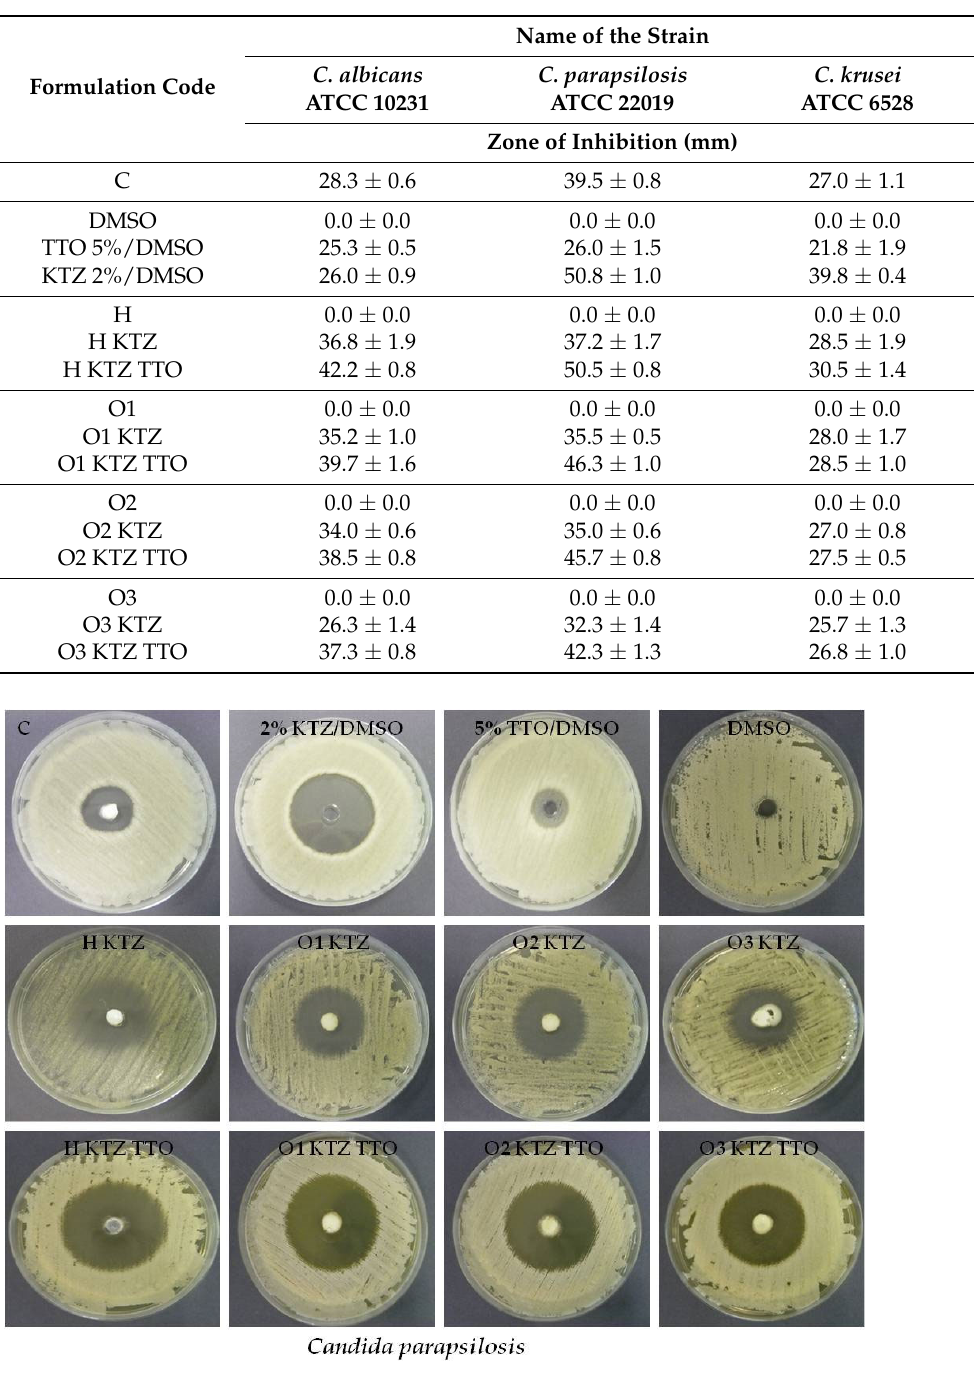
Table 6. Antifungal activity of prepared PLU ® F-127 hydrogels and PLO organogels containing KTZ (H KTZ, O1 KTZ, O2 KTZ, O3 KTZ), KTZ and TTO (H KTZ TTO, O1 KTZ TTO, O2 KTZ TTO, O3 KTZ TTO),and controls: placebo gels (H, O1–O3), KTZ 2% in DMSO, TTO 5% in DMSO, and commercially available product (C). Values are expressed as means ± SD of six replicates.